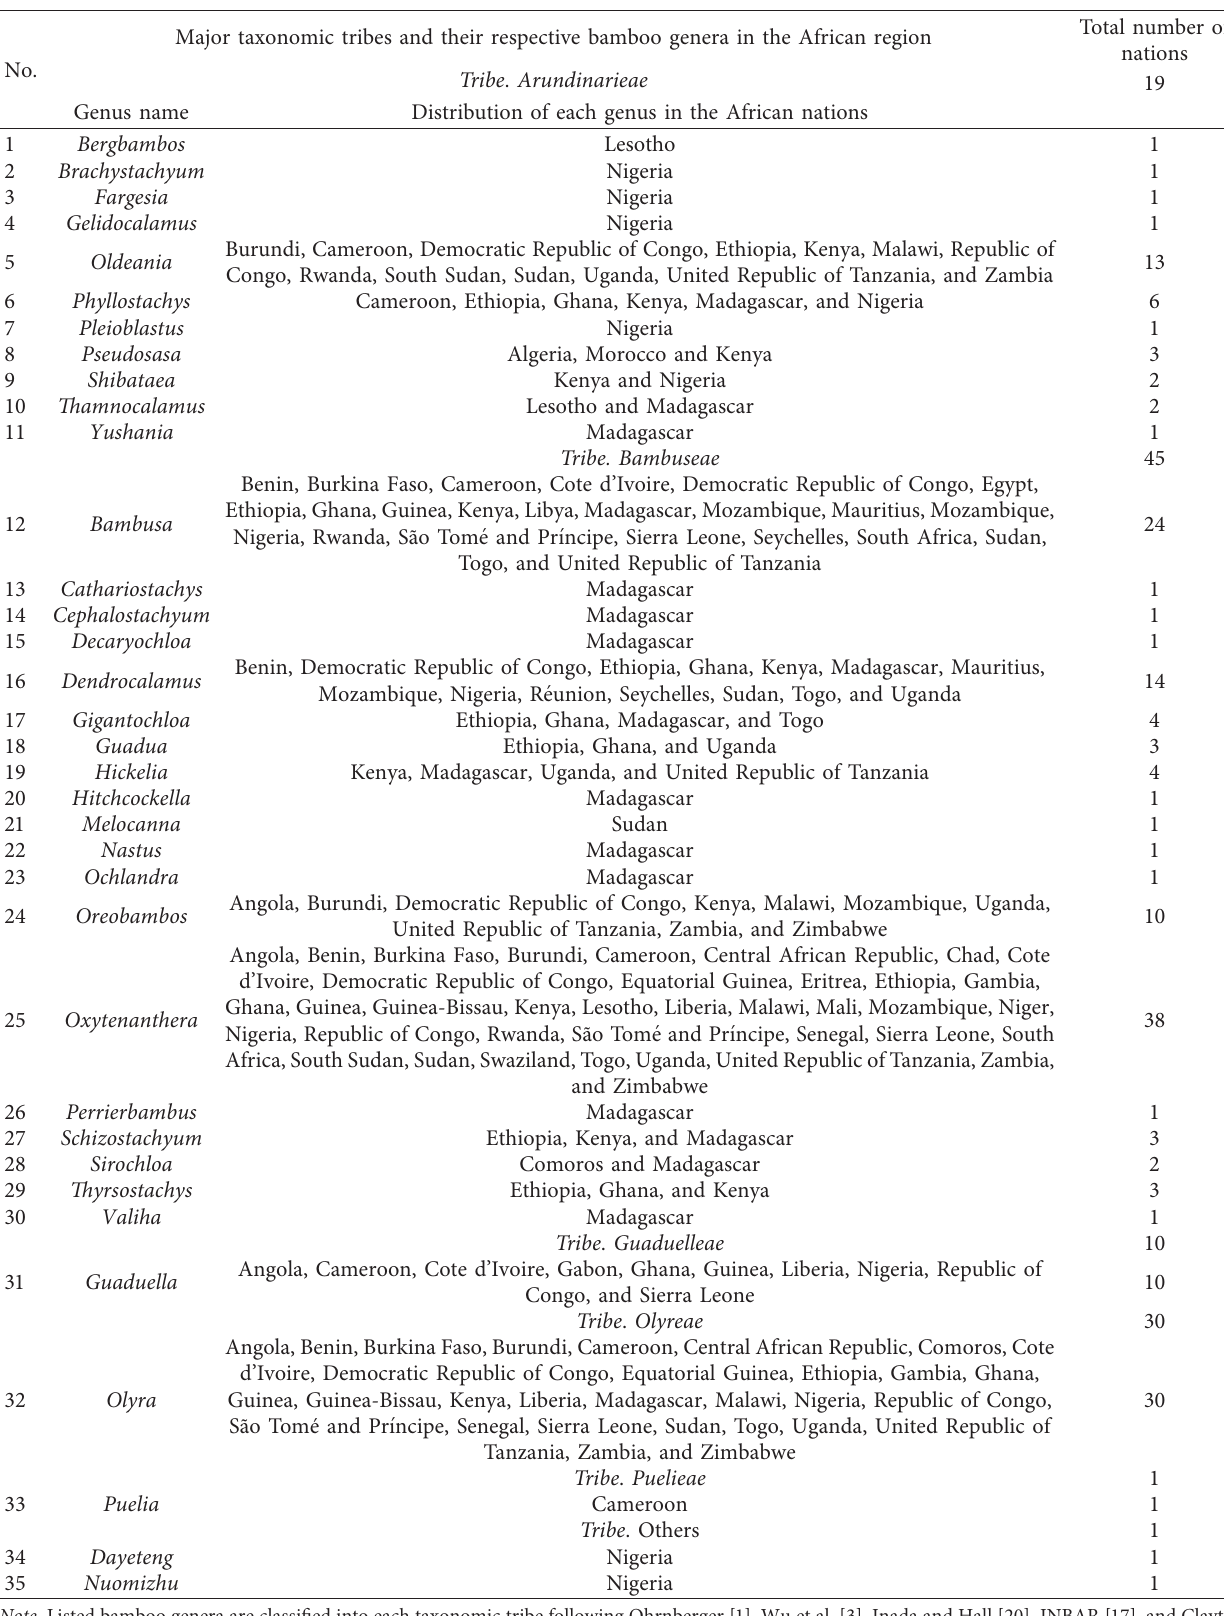
Table 3: A checklist of bamboo genera classified into taxonomic tribes in the African region. Major taxonomic tribes and their respective bamboo genera in the African No.